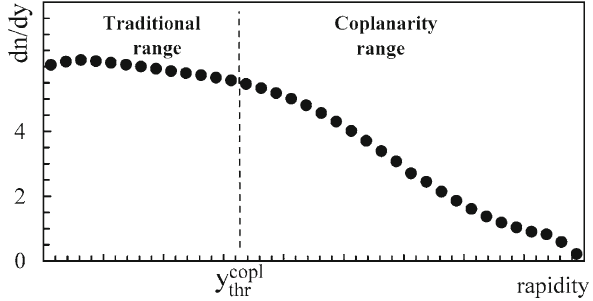
Fig. 3 Qualitative scheme of traditional and coplanarity ranges of dn ch / dy distribution